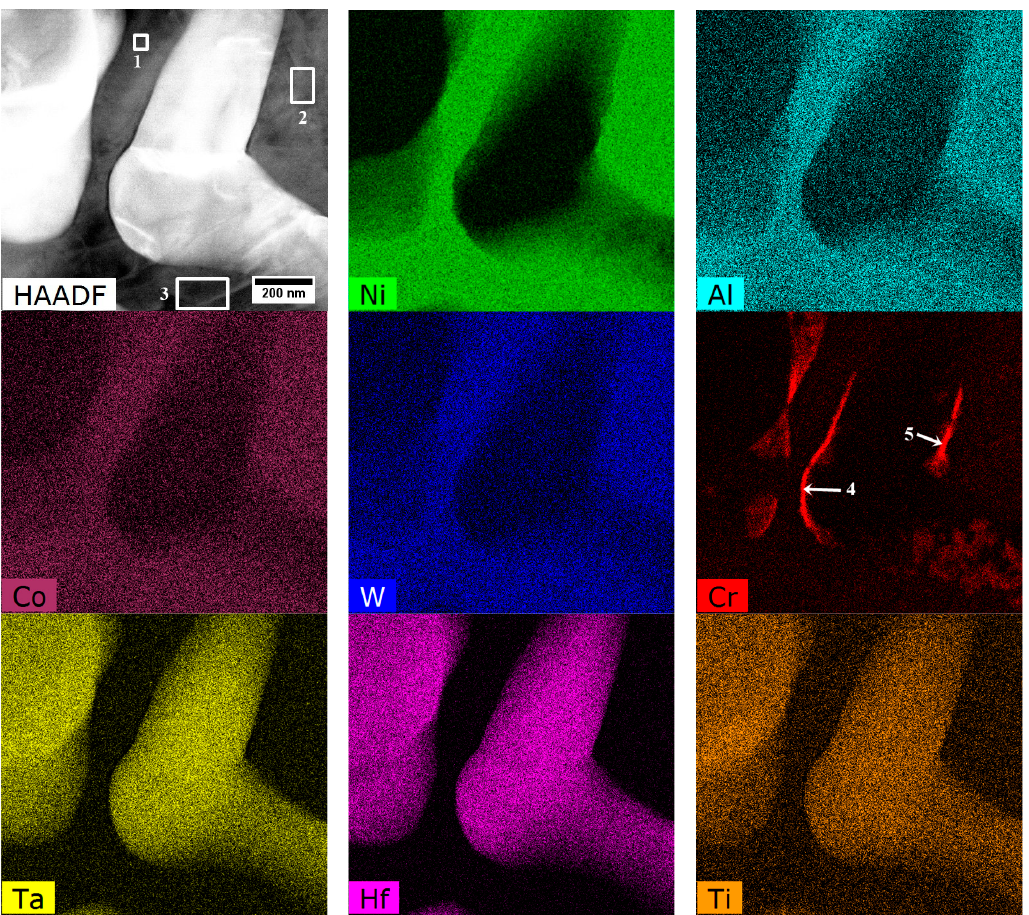
Figure 19. Distribution of selected alloying element in the fragment of "Chinese script" carbide, STEM-EDX. Table 7. Chemical composition of the coarse secondary γ ' and M 23 C 6 (at the MC carbide edge), at%. Area